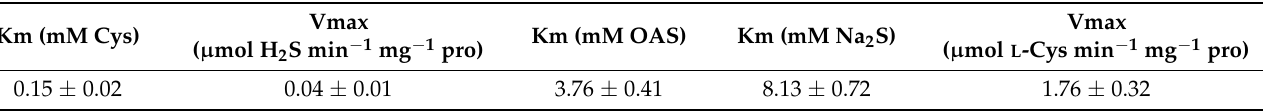
Table 2. Catalytic properties of the recombinant His -tagged OsLCD1 for the CDes and OAS-TL enzymatic reactions. L -Cys was used as a substrate for the DES reaction, whereas OAS and Na 2 S were used as co-substrates for the OAS-TL reaction. Lineweaver – Burk plot was performed to calculate the kinetic constants.